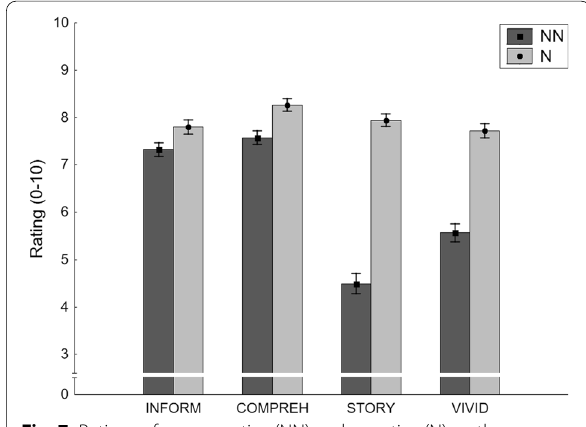
Fig. 7 Ratings of non-narrative (NN) and narrative (N) myth corrections on informativeness (INFORM), comprehensibility (COMPREH), story-ness (STORY), and vividness (VIVID) in the Experiment 2 Pilot. Error bars indicate within-subjects standard error of the mean